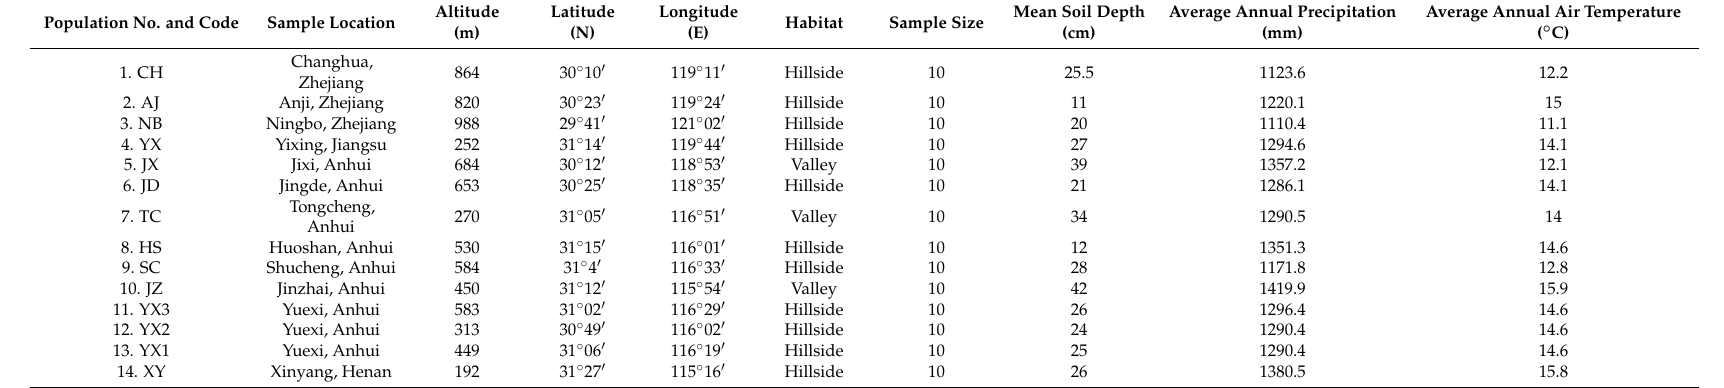
Table 1. Details of sample locations and sizes of 14 populations of Parrotia subaequalis (H. T. Chang) R. M. Hao et H. T. Wei from eastern China. Population No. and